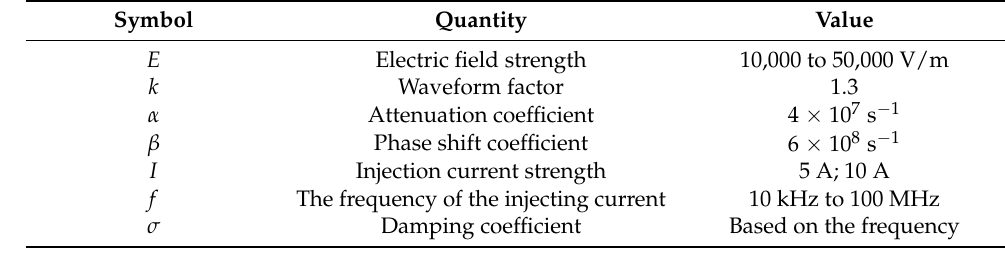
Figure 6. Main fuel regulation control system in the injection test. By monitoring the signals and phenomena, the sensitivity thresholds of the sensors could be obtained, which provided a reference for electromagnetic pulse protection. The parameters of (1) and (2) are listed in Table 1. Table 1. Parameters for Equation.